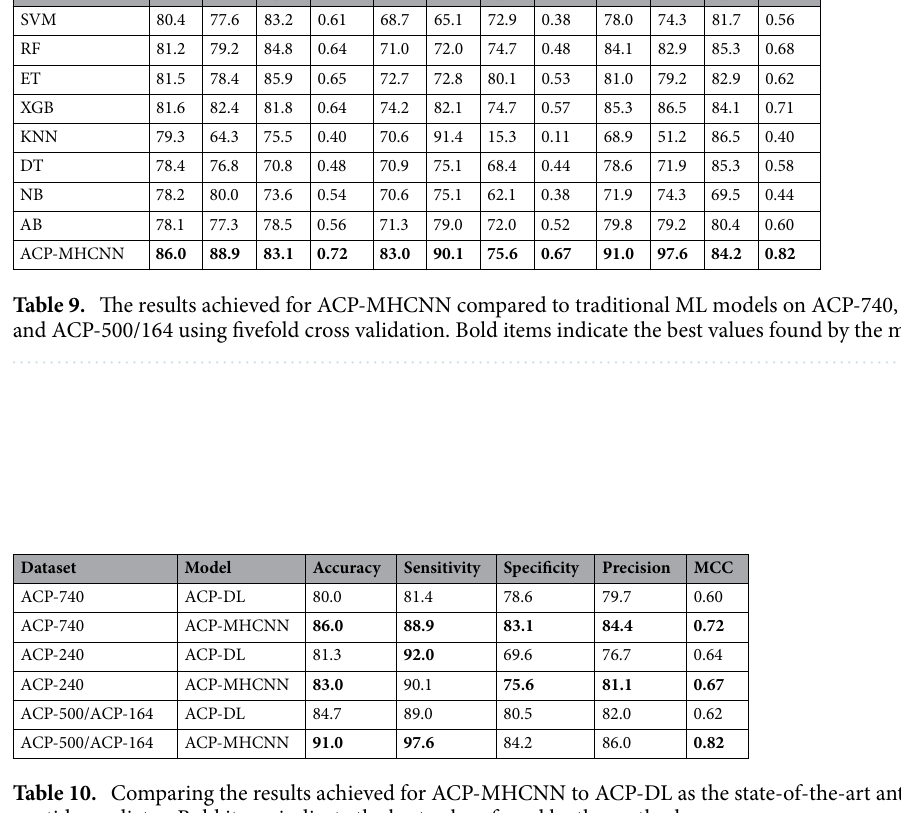
Table 10. Comparing the results achieved for ACP-MHCNN to ACP-DL as the state-of-the-art anticancer peptide predictor. Bold items indicate the best values found by the